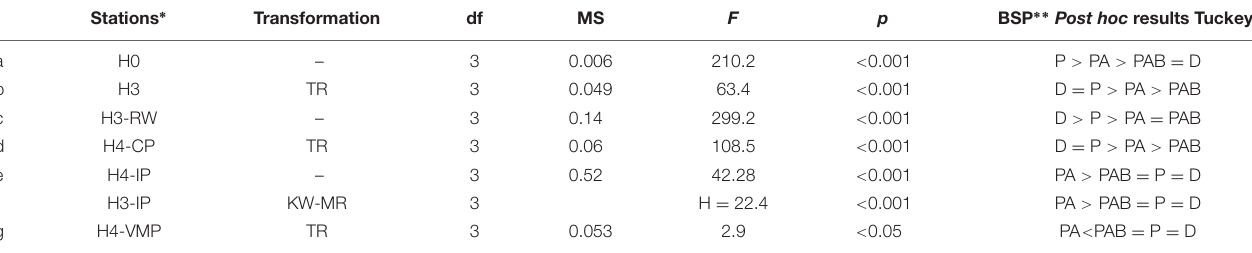
TABLE 3 | One-way ANOVA results for bacterial secondary production (BSP) after incubation under different solar radiation treatments. Stations